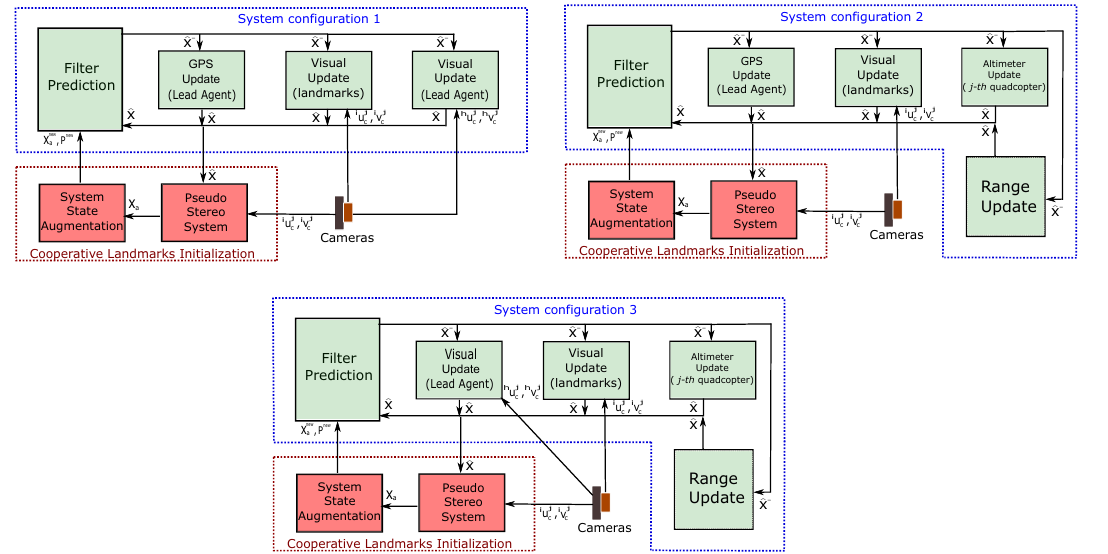
Figure 5. EKF-Cooperative SLAM: Block diagram showing the architecture of the system under its three